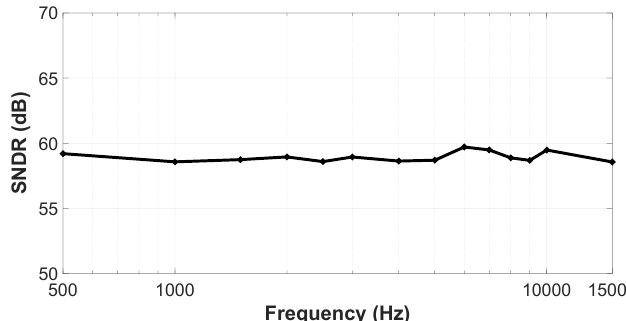
Figure 15. Measured frequency response (500 Hz to 15 kHz) for an input signal of 94 dB SPL (12 mV rms